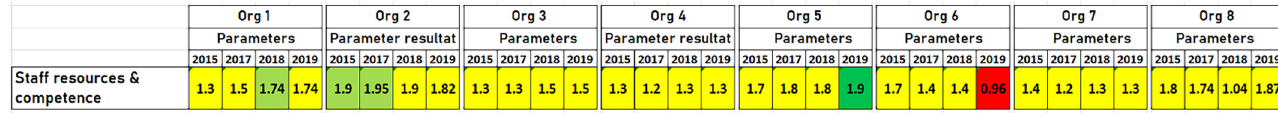
Figure 13. Result for parameter “Personnel resources and competence” for organizations in this study.